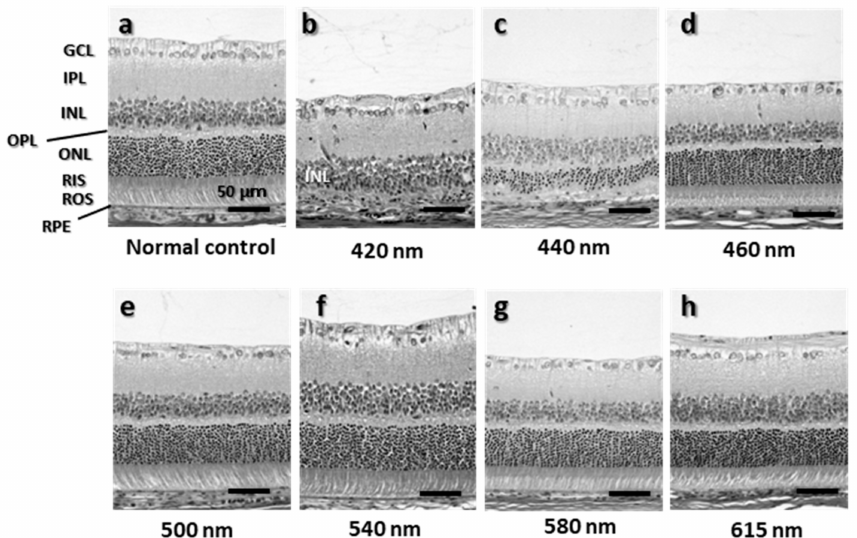
Figure 4. H&E of the retina 500–1000 µ m superior the optic nerve. ( a ) Normal control retinas. ( b – h ) Light-exposed retinas exposed to following wavelengths: 420 nm, 440 nm, 460 nm, 500 nm, 540 nm, 580 nm, and 615 nm. GCL, ganglion cell layer; IPL, inner plexiform layer; INL, inner nuclear layer; OPL, outer plexiform layer; ONL, outer nuclear layer; RIS, rod inner segments; ROS, rod outer segments; RPE, retinal pigment epithelium. Bar = 50 µ